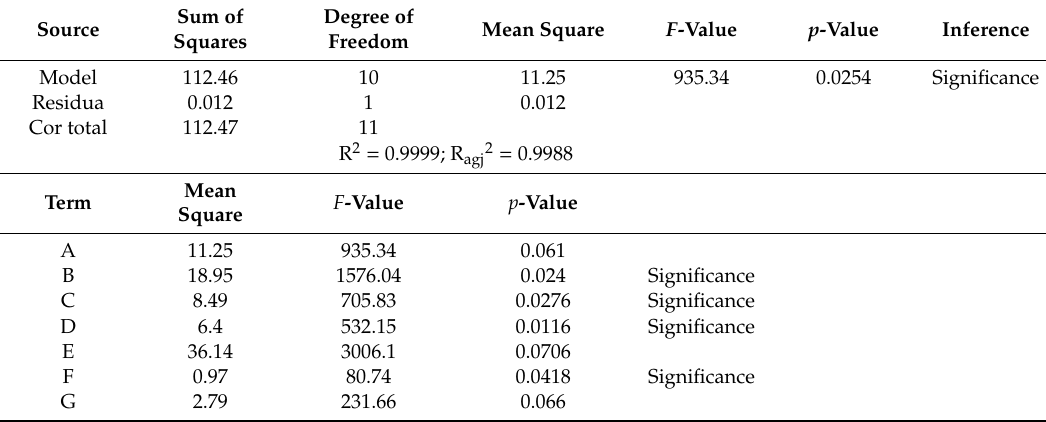
Table 2. Analysis of variance (ANOVA) and regression analysis of PB design for the prediction of significant extraction